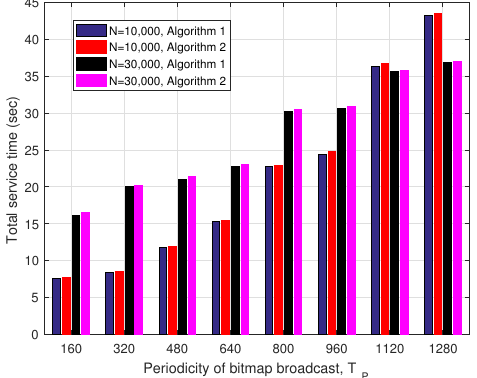
Figure 7. TST vs. periodicity of bitmap broadcast, T P .